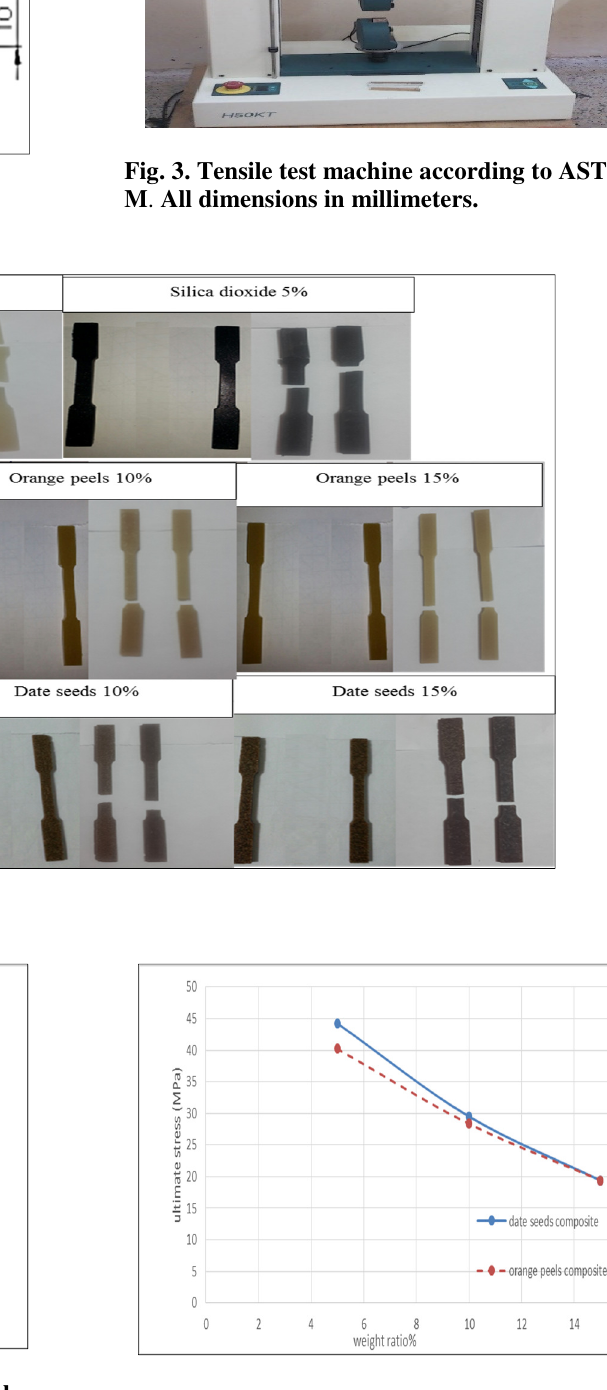
Fig. 6. Effect of weight ratio on ultimate stress (natural